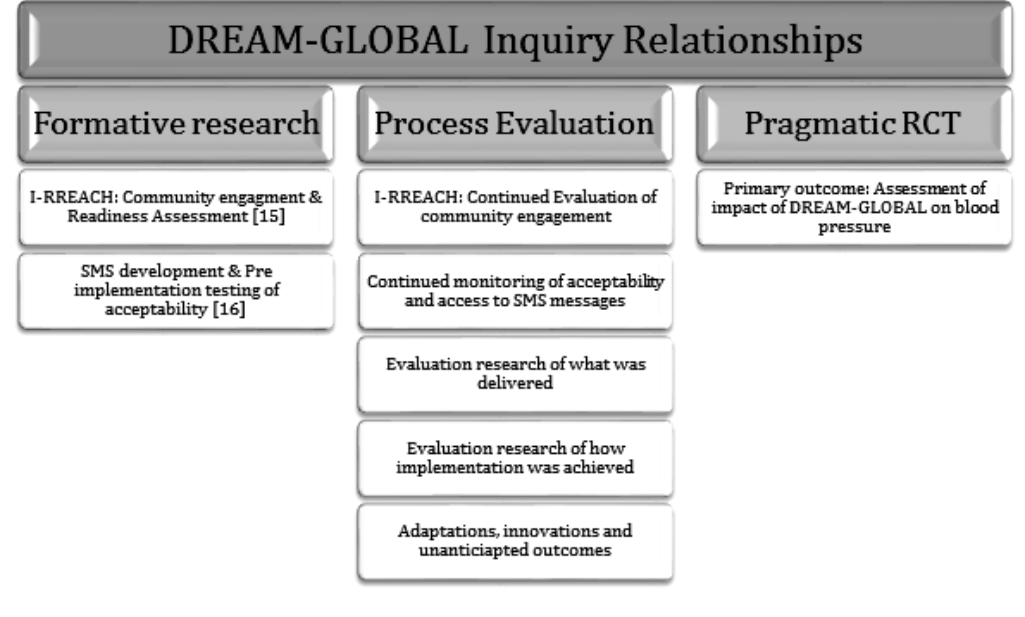
Figure 1. DREAM-GLOBAL process evaluation relationship to formative research and trial research (I-RREACH, Intervention and Research Readiness Engagement and Assessment of Community Health